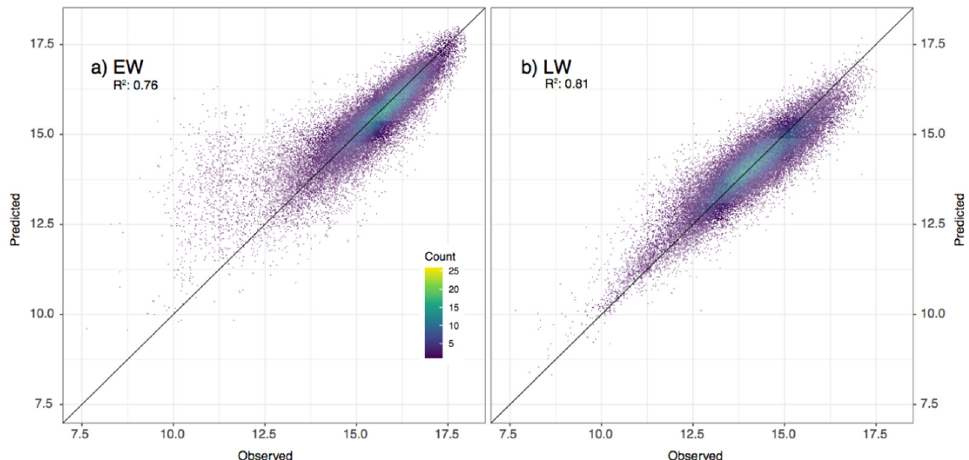
Figure 5. ( a ) EW and ( b ) LW widths predicted using each model compared with the measurements. The explained variance of the models (r 2 ) is shown.